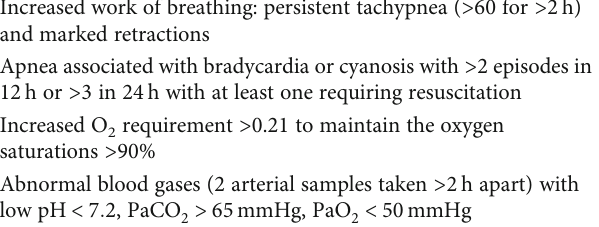
Table 5: Stability criteria for weaning from NCPAP. CPAP pressure of 5cm H O 2